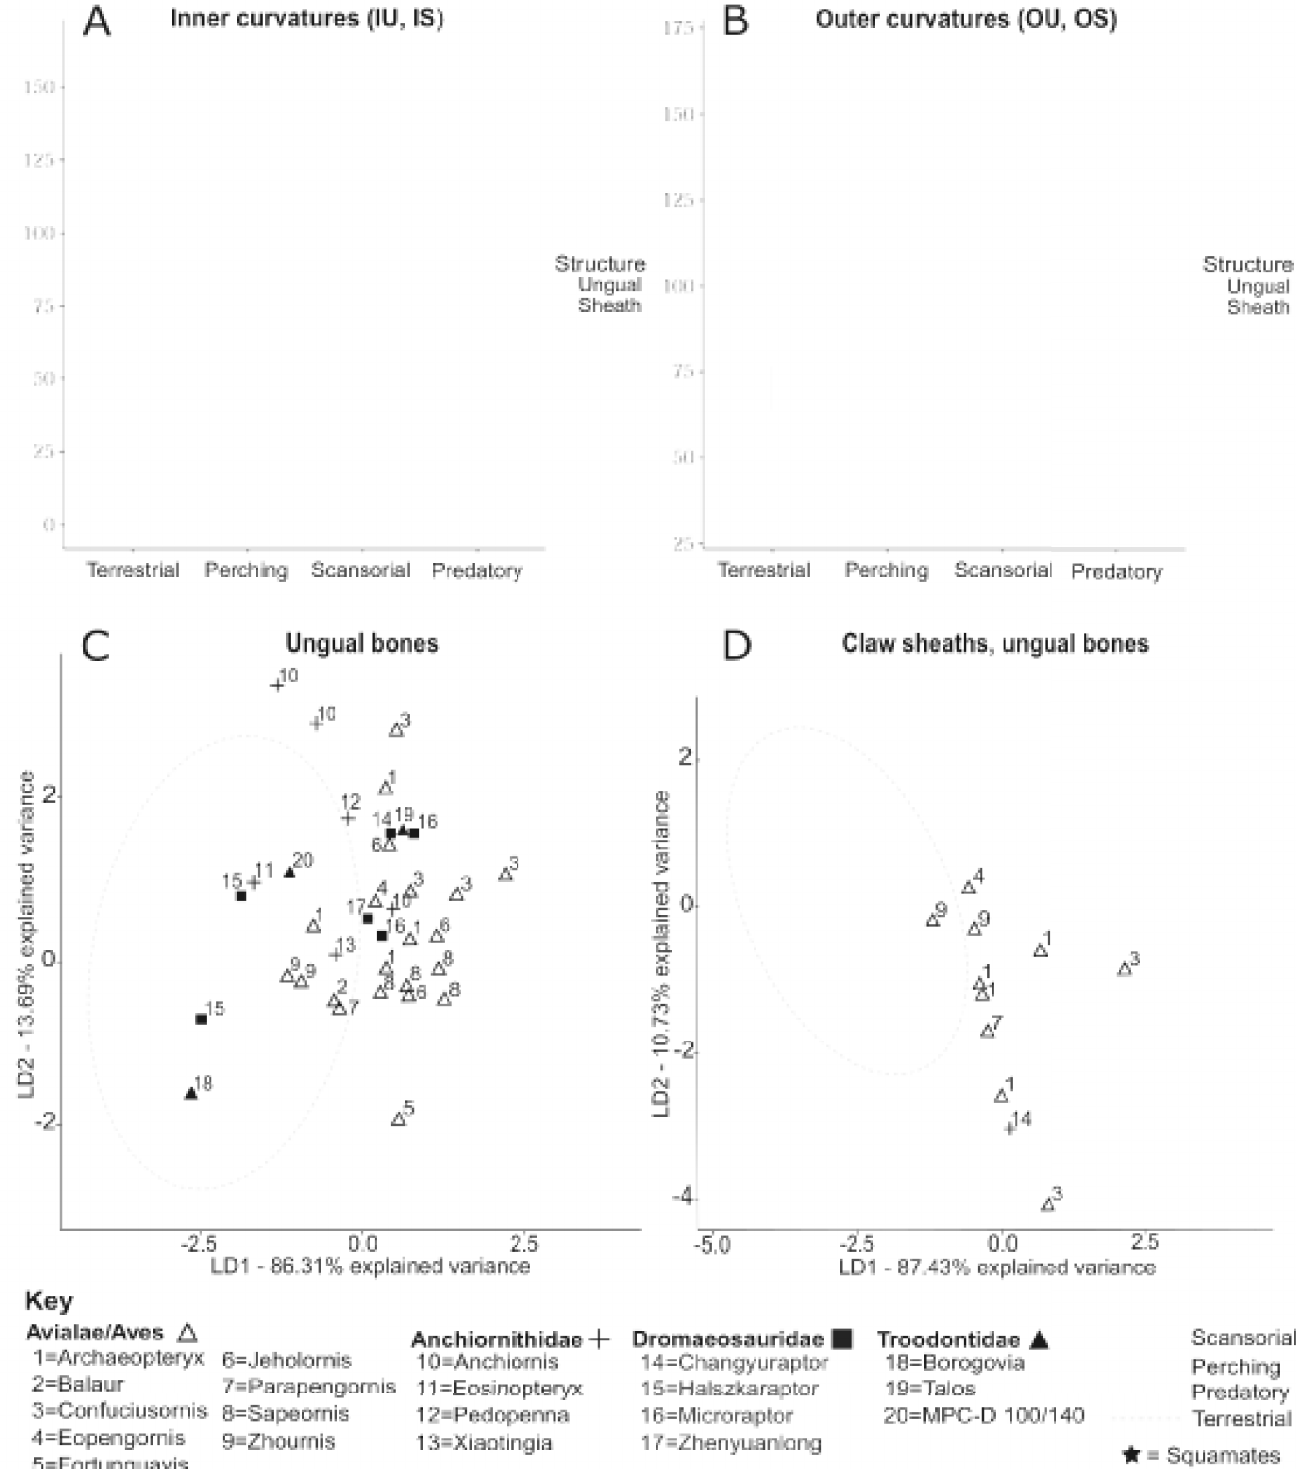
PLOS ONE | https://doi.org/10.1371/journal.pone.0211173 February 5,